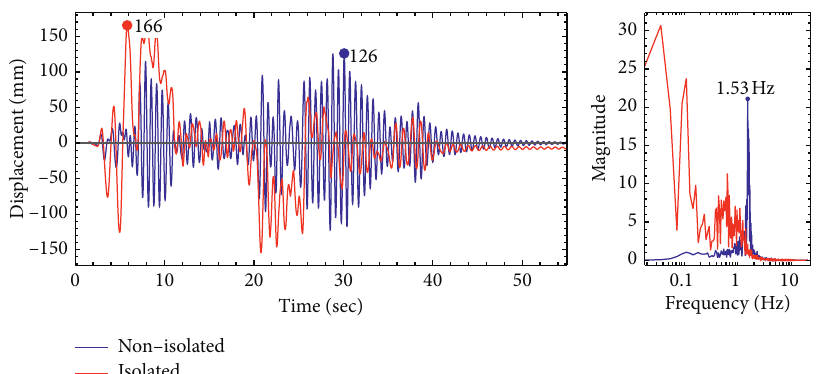
Figure 16: Response histories and corresponding Fourier spectra of the relative top displacement of the nonisolated and isolated system with 2% damping at 0.2 (g) seismic qualification level under α �